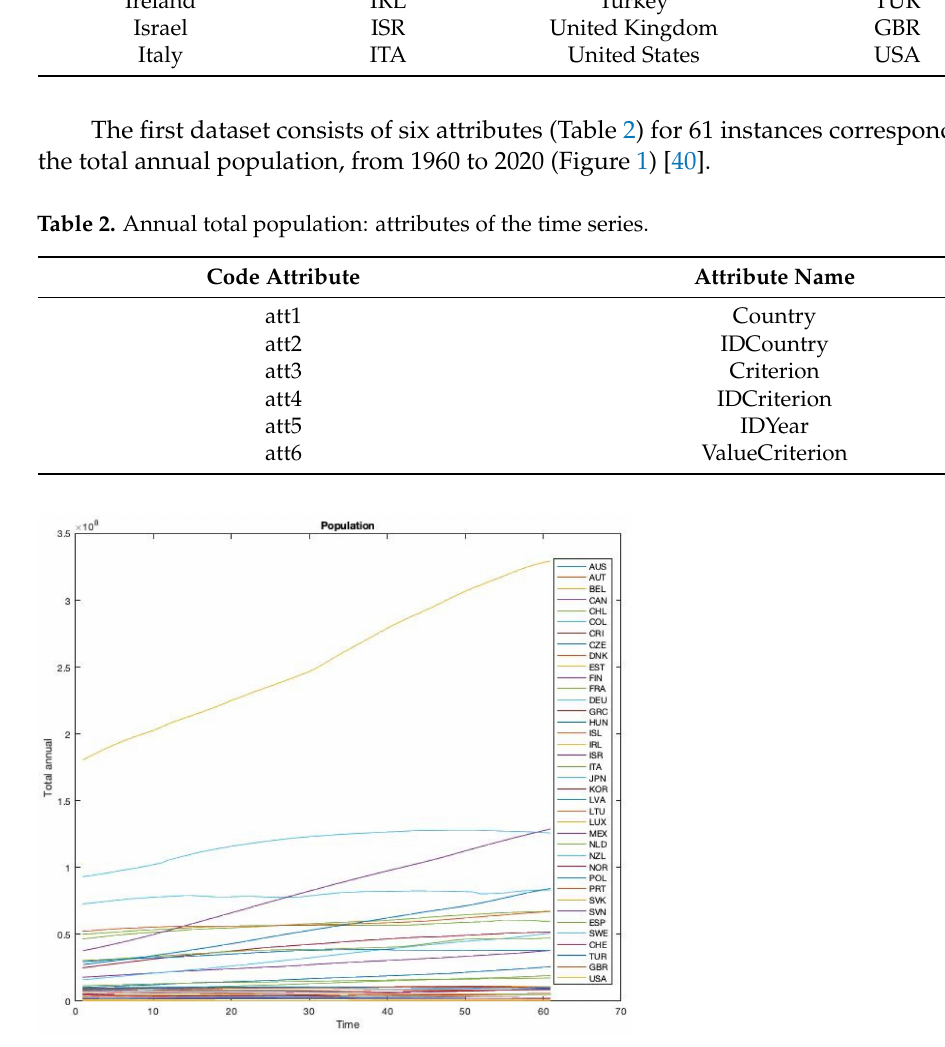
Figure 1. OECD member countries: total annual